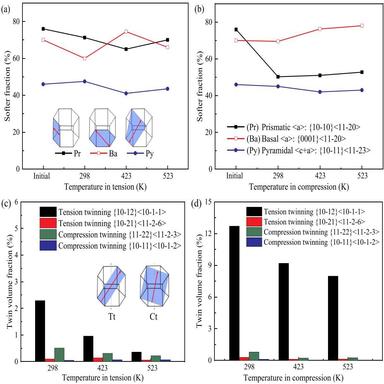
Volume fraction of the grains with a softer orientation (Schmid factor > 0.25 for Ba, Pr, or Py slip) in (a) tension and (b) compression and, twin area fraction in (c) tension and (d) compression, indicating that Pr, Ba, Py, Tt and Ct can be regarded as the dominant deformation mechanisms of the α-Ti tube.